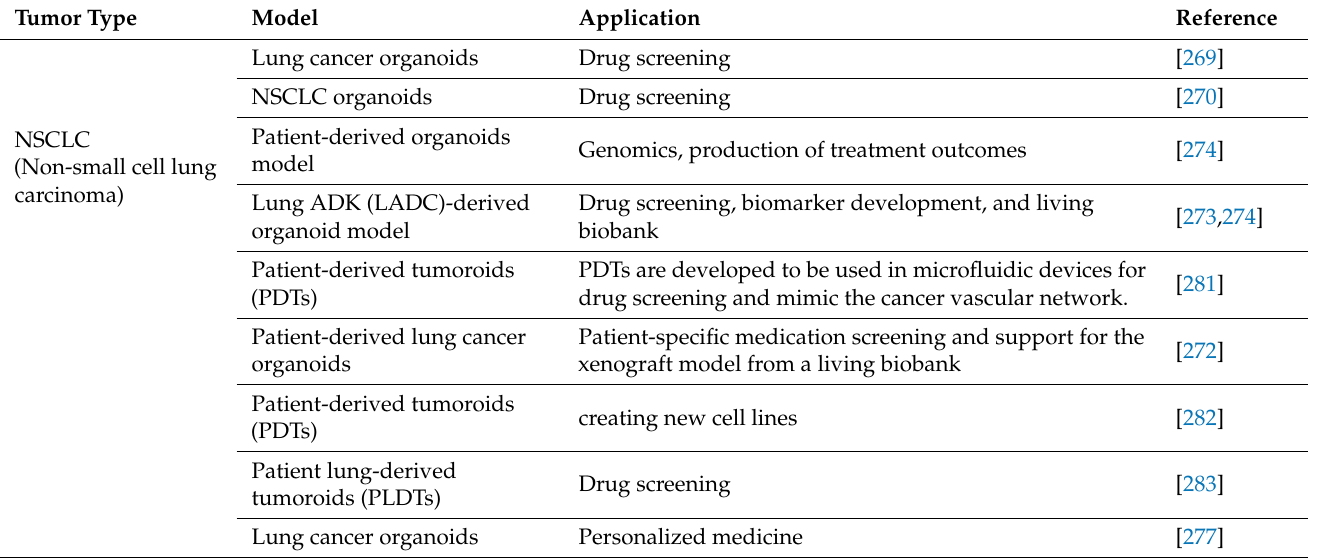
Table 5. Currently used lung organoids and tumoroids models in NSCLC